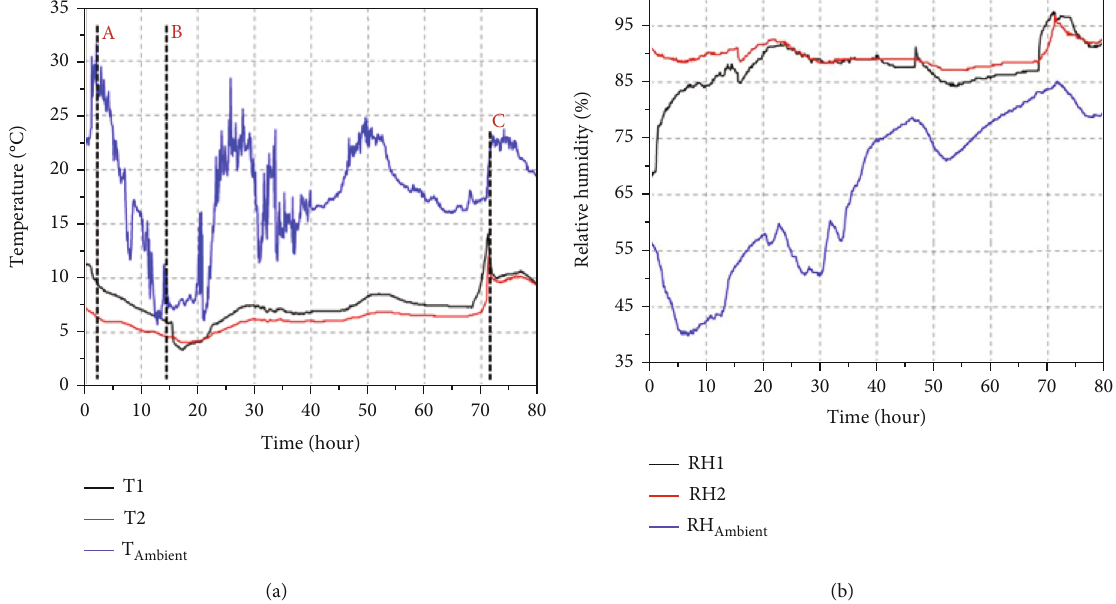
Figure 5: Time evolution of the temperature and RH inside the loaded conditioner under dynamic conditions (vertical direction, a: temperature, b: relative